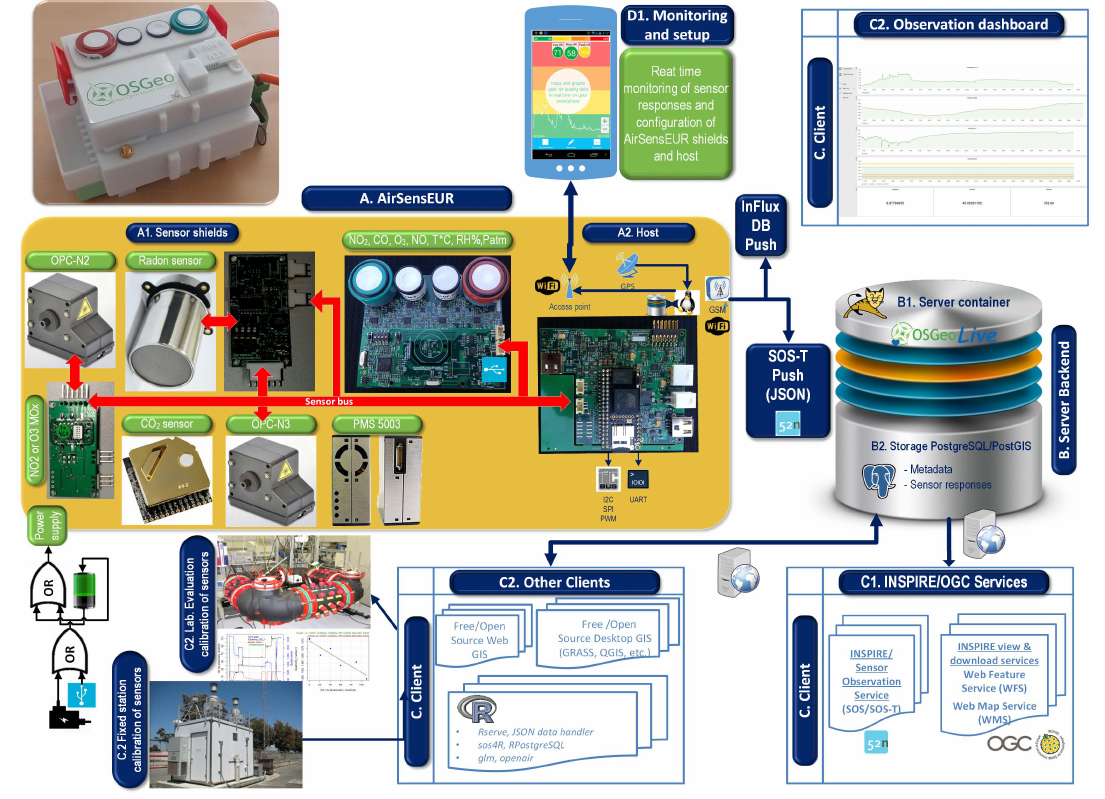
Figure 3. The AirSensEUR Platform. Source: [43]